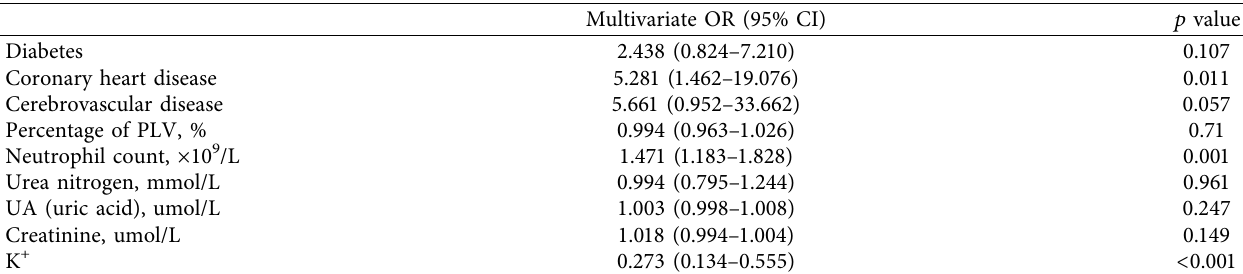
Table 5: Multivariate logistic regression analysis of patients with COVID-19 and